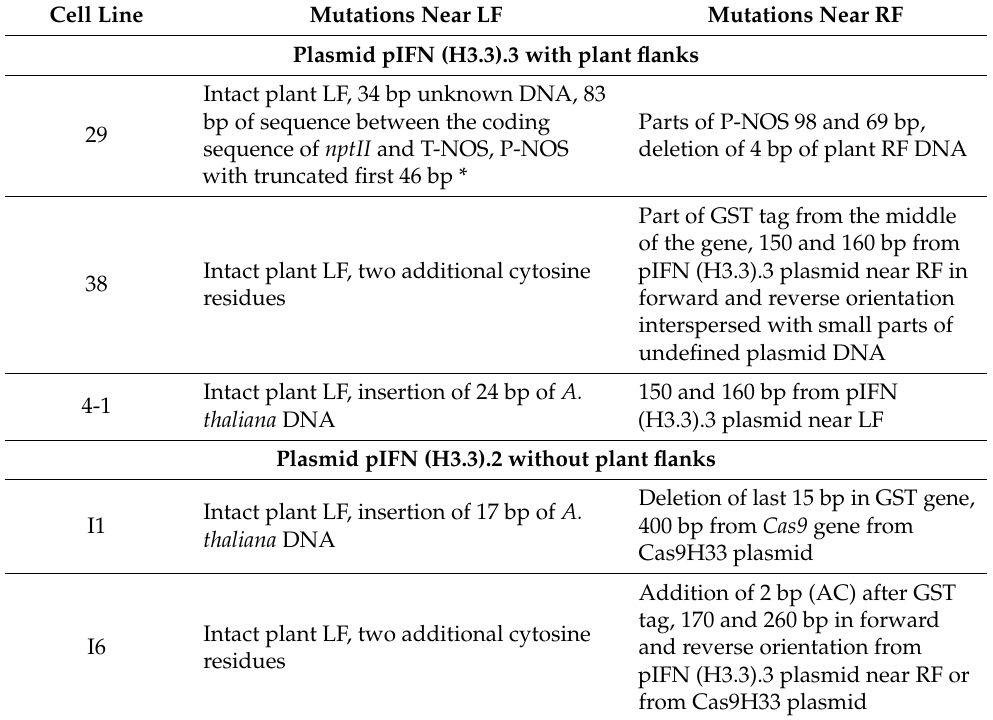
Table 2. Mutations from the left (LF) and right (RF) flanking sequences in the studied cell lines. Cell Line Mutations Near LF Mutations Near RF